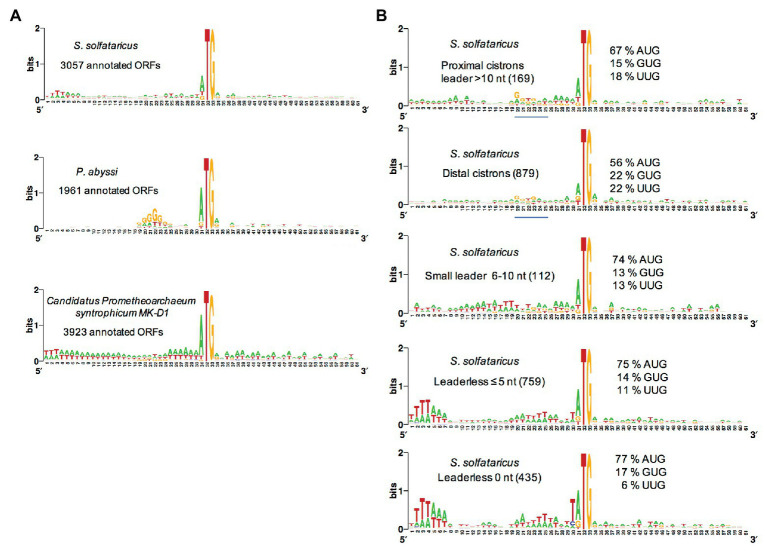
Analysis of translation start regions. (A) Analysis of the translation start regions in Sulfolobus solfataricus, P. abyssi, and the Asgard Candidatus Prometeoarchaeum syntrophicum. DNA sequences (60 nt around the first base of the start codon) were extracted from the genomic sequences (She et al., 2001; Cohen et al., 2003; Imachi et al., 2020). Annotations as corrected by Wurtzel et al. (2010) have been used for S. solfataricus. Sequence logos were created using Weblogo (Crooks et al., 2004). (B) Detailed analysis of the translation start regions in S. solfataricus. See also Tolstrup et al. (2000) for an earlier analysis. For each indicated category of transcript (number of ORFs in parentheses), the percentage of AUG, GUG, and UUG start codons are indicated. The position of potential 16S rRNA binding sites (Shine-Dalgarno sequences) in the upper two logos is shown by a blue line. Note that in fully leaderless genes (0 nt), the occurrence of T at the −1 position and the avoidance of UUG as start codon are likely linked to signals for RNA polymerase.